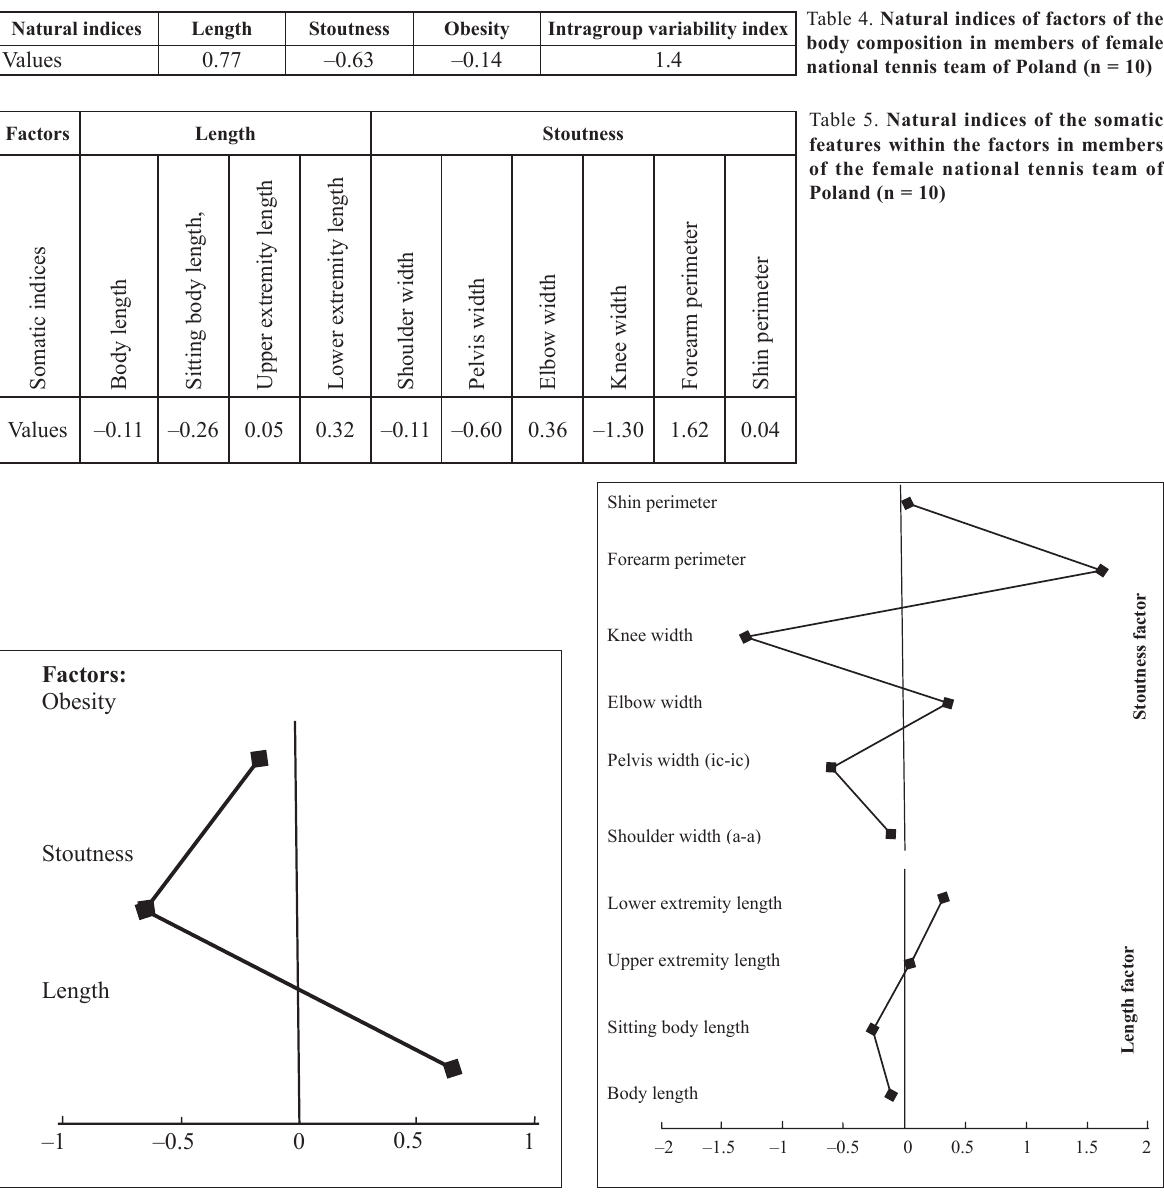
Table 5. Natural indices of the somatic features within the factors in members